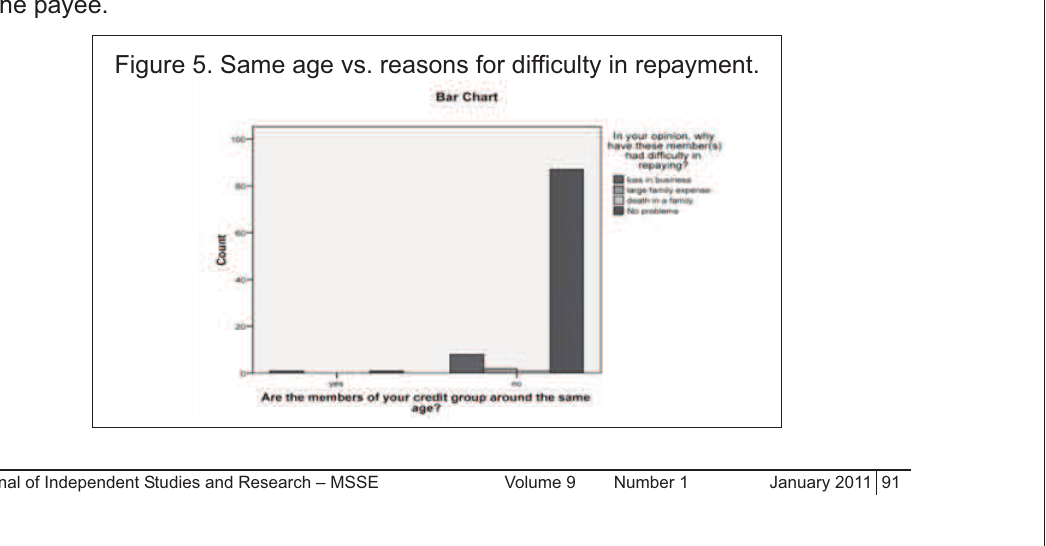
Figure 5. Same age vs. reasons for difficulty in